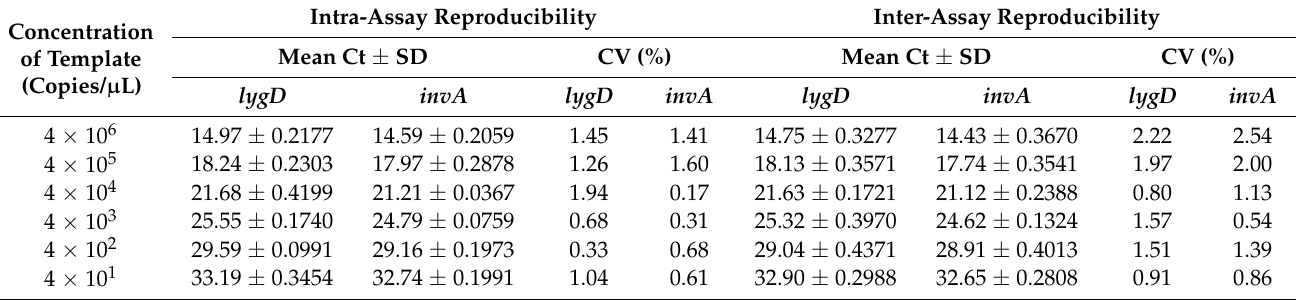
Table 3. Intra- and inter-assay reproducibility results of the developed TaqMan real-time PCR assay.